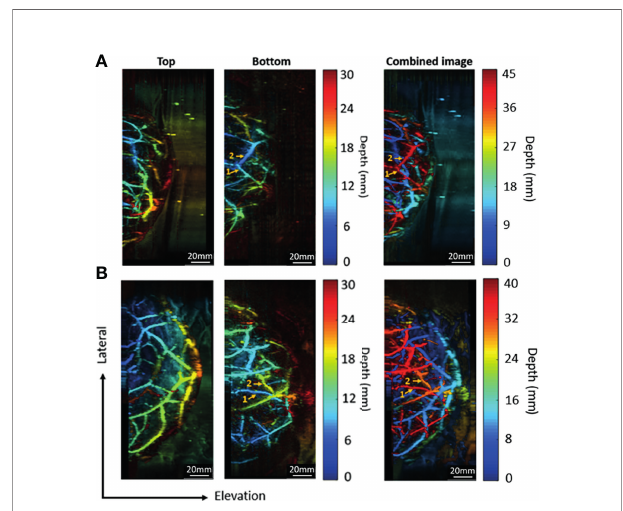
FIGURE 8 | Combination of images acquired by the top and bottom transducers. (A) The imaging results for a breast cup size of C. (B) The imaging results for a breast cup size of D. The left two columns show the images acquired by the top and the bottom transducers, respectively. The right column shows the combined image.